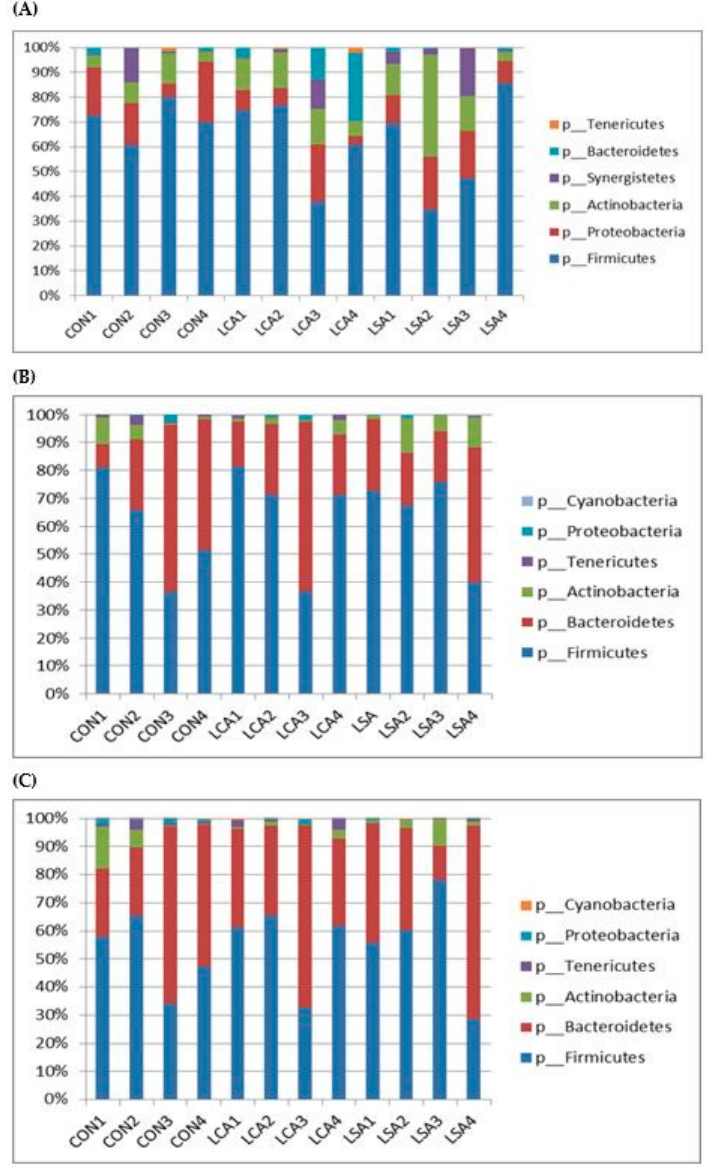
Figure 2. Effect of feeding milk replacer (MR) with low antibiotics concentration cocktail or single on the phyla composition in the ileum, colon and rectum. A = ileum; B = colon and C = rectum. CON = control; LCA = low cocktail of antibiotics concentration; LSA = low concentration of single antibiotic. The values are the mean plus standard deviation.